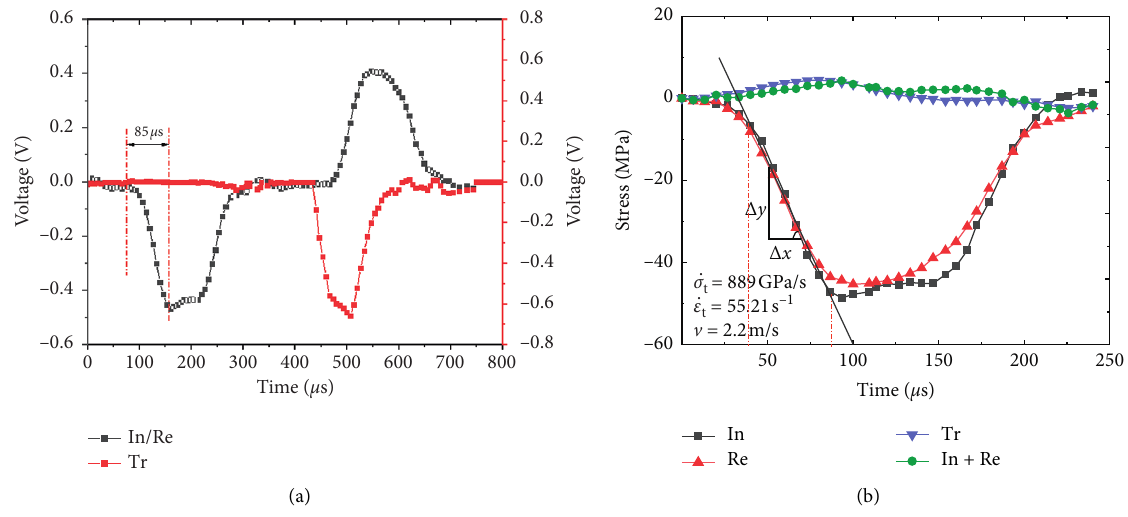
Figure 3: Evolution curves of the voltage (a) and stress (b) with Figure 3(b) is the obtained stress time history curve. The rising edge of the incident stress and the reflected stress curve nearly overlapped, and the linear slope of the in- creasing incident stress can be considered as the loading rate.